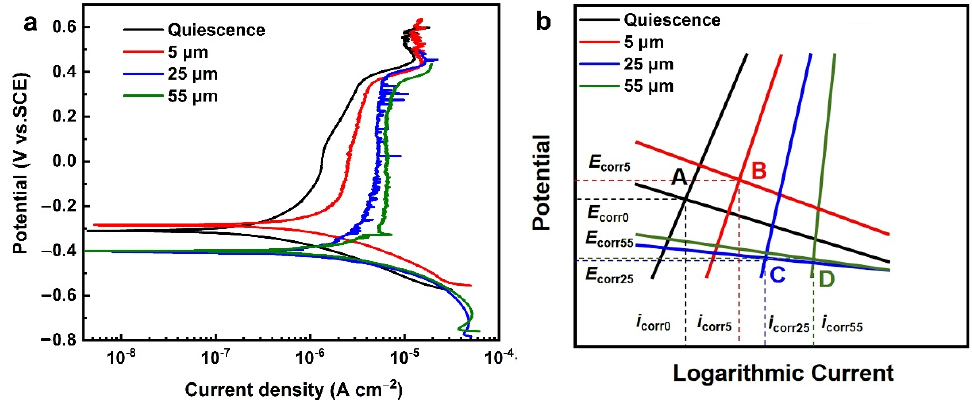
Figure 5. ( a ) Potentiodynamic polarization plots of 316L SS at different CE amplitudes. ( b ) Schematic diagram of ideal polarization curve of 316L SS at different CE amplitudes. Table 2. Fitting values of electrochemical parameters obtained from potentiodynamic polarization plots at different CE amplitudes.